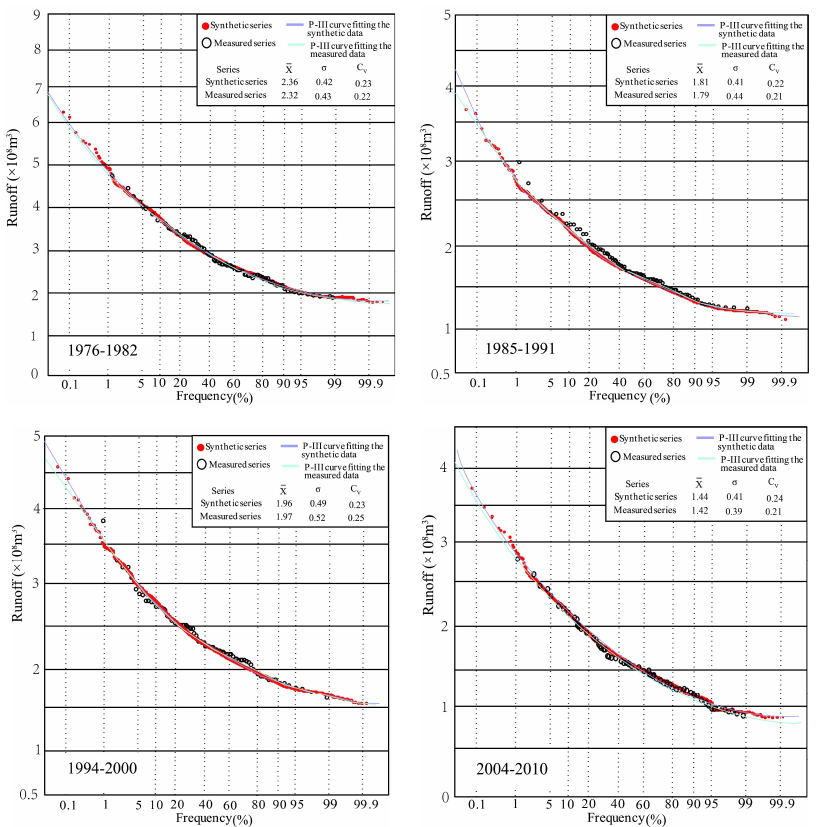
Figure 16. P-III frequency curves fitting segmented synthetic and measured runo ff series and statistical